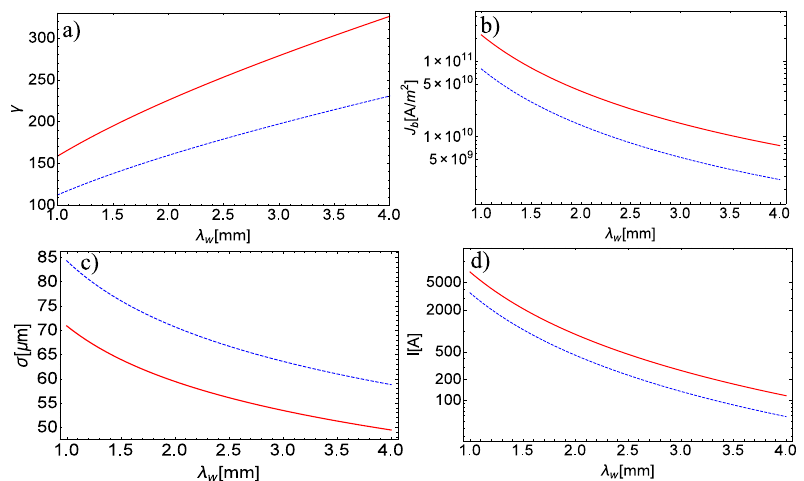
Figure 14. Electron beam energy ( a ), electron beam current density ( b ), the electron beam transverse section ( c ) and the peak current ( d ) vs. the RF wavelength λ w for two FEL radiation λ r = 10 nm (continuous line) and λ r = 20 nm (dashed